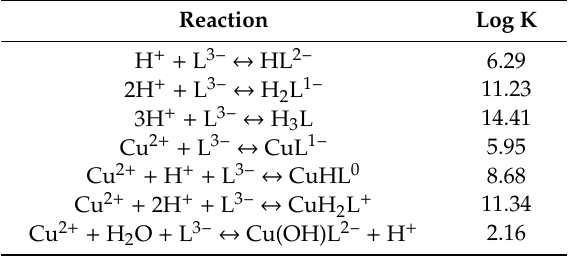
Table 3. Equilibrium constants for citric acid and copper citrate complexes at 298